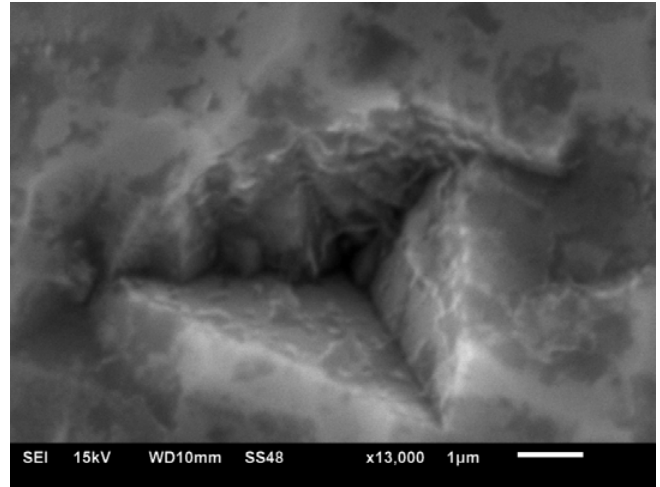
Figure 10. SEM image of nano-impact (Berkovich) residual impression on amorphous NiTi film surface at 100